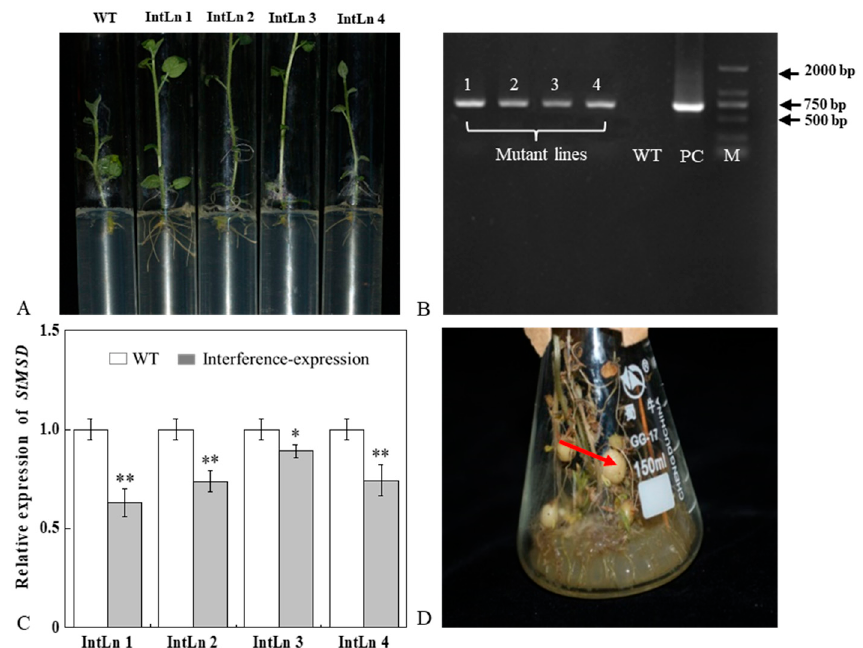
Figure 1. Acquisition and verification of StMSD interference-expression potato plantlets and tubers: ( A ) rooting screening of StMSD -interference plantlets; ( B ) PCR identification of genomic DNA from Kana-resistant potato plantlets, in which 1–4 are the obtained interference-expression plantlets, WT is the wild type plantlets, PC is the positive control, M is a 2 Kb ladder Marker; ( C ) quantitative RT-PCR analysis of StMSD in the interference-expression plantlets; ( D ) induction of interference-expression potato tubers (the red arrow shows the tubers). Bars indicate standard deviation (±SD). Asterisks represent significant differences ( ∗ p < 0.05; ∗∗ p < 0.01).